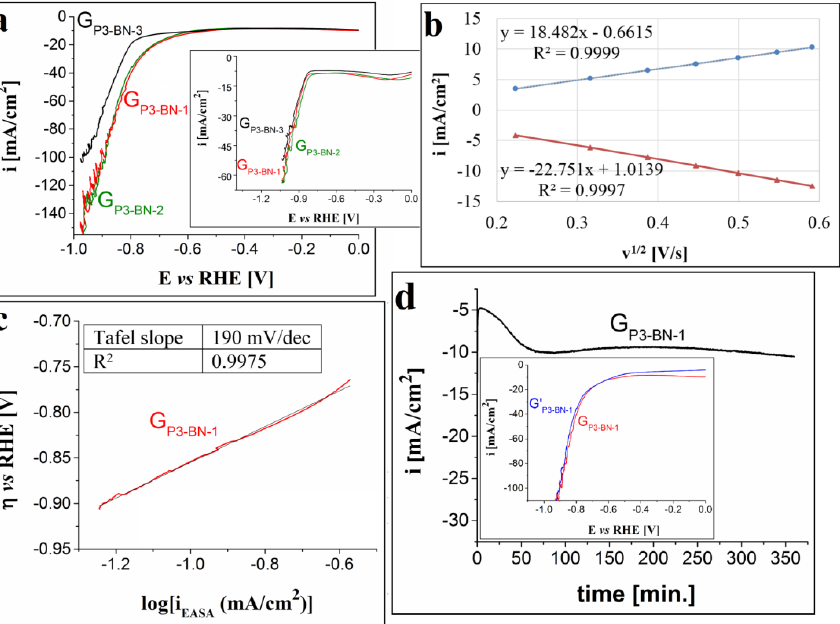
Figure 8. ( a ) Cathodic voltammograms traced on the G P3-BN-1 , G P3-BN-2 and G P3-BN-3 electrodes in 1M KOH solution, at v = 5 mV/s. Inset shows the LSVs recorded on the same electrodes, but in 0.1M KOH solution. ( b ) The plot of the anodic and cathodic peak current densities vs. the square root of the scan rate for the G P3-BN-1 electrode. ( c ) The Tafel plot obtained for the G P3-BN-1 electrode in 1M KOH solution. ( d ) i-time curve traced on the G P3-BN-1 electrode in 1M KOH solution and inset showing the voltammograms recorded on the electrode before and after the stability test (coded as G P3-BN-1 and G’ P3-BN-1 ).